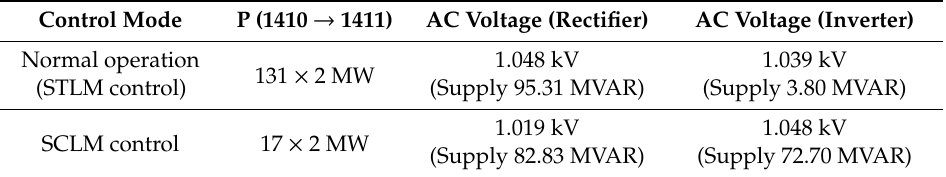
Table 7. HVDC setpoint change using the SCLM control for the transformer overload.